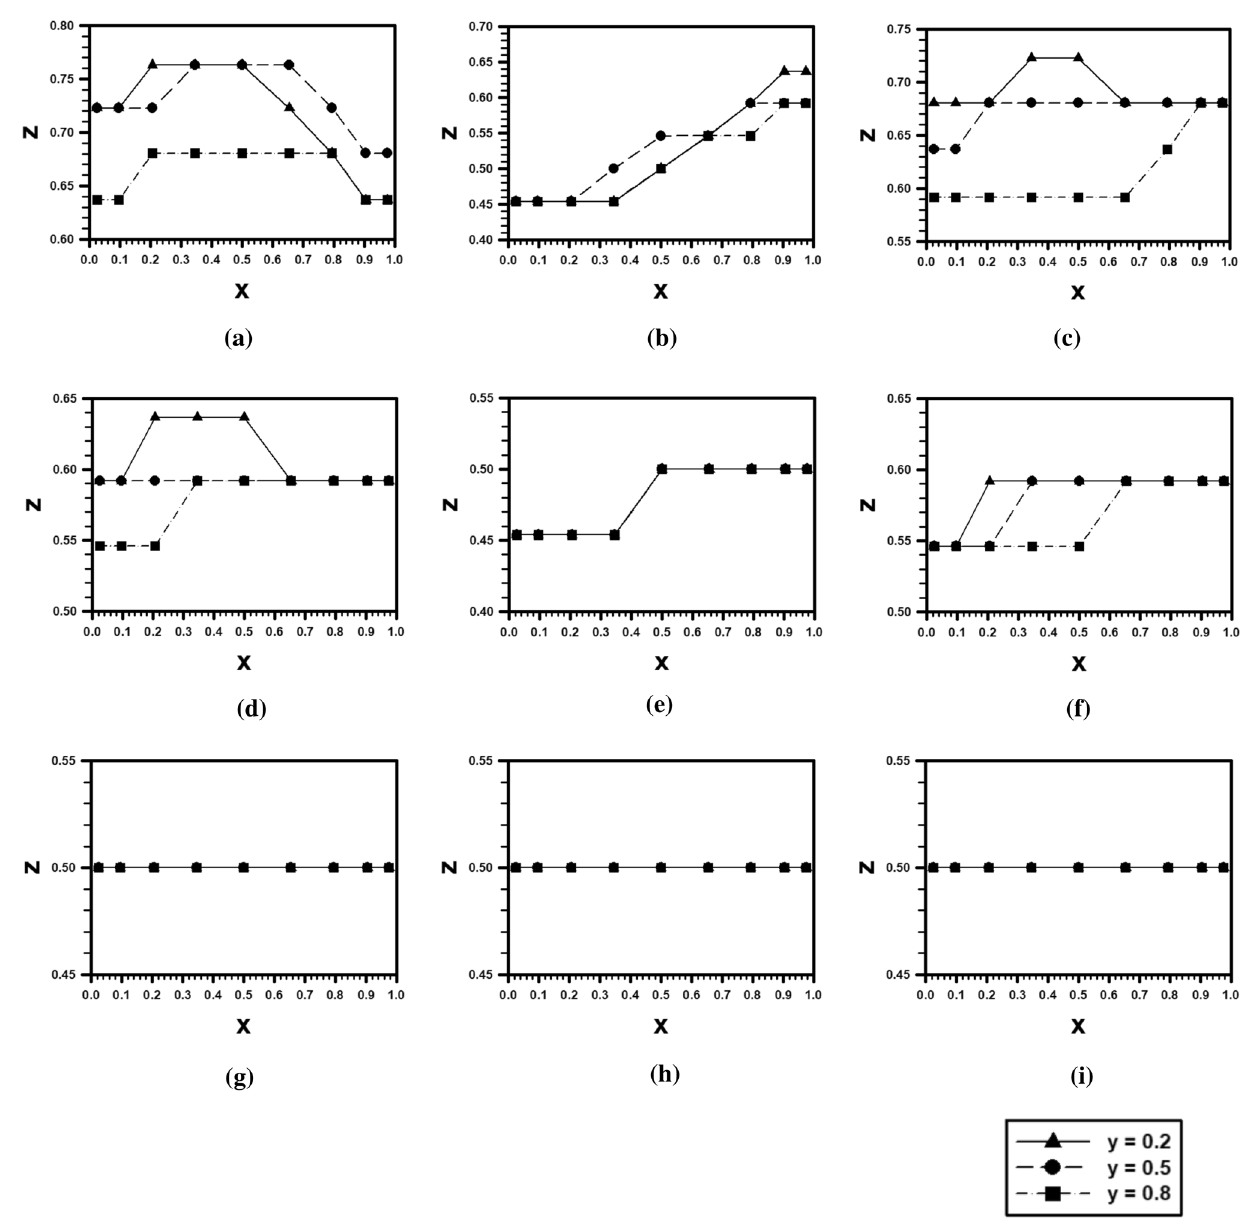
Fig. 12 A sample of the position of the maximum velocities of a longitudinal, b depth and c transverse for velocities of d longitudinal, e depth and f transverse for